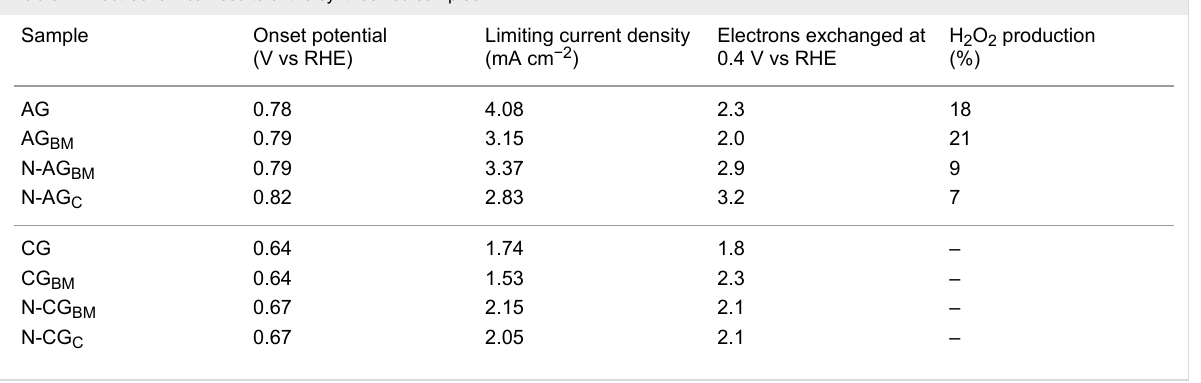
Table 2: Electrochemical results of the synthesized samples.